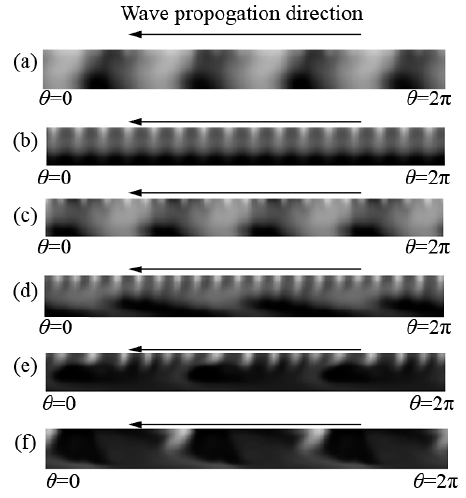
Figure 13. Snapshots of circumferential view of concentration fluctuation when Re T = 6.0 × 10 3 . ( a ) Re s = 234; ( b ) Re s = 468; ( c ) Re s = 935; ( d ) Re s = 1403; ( e ) Re s = 1870; ( f ) Re s = 3506.